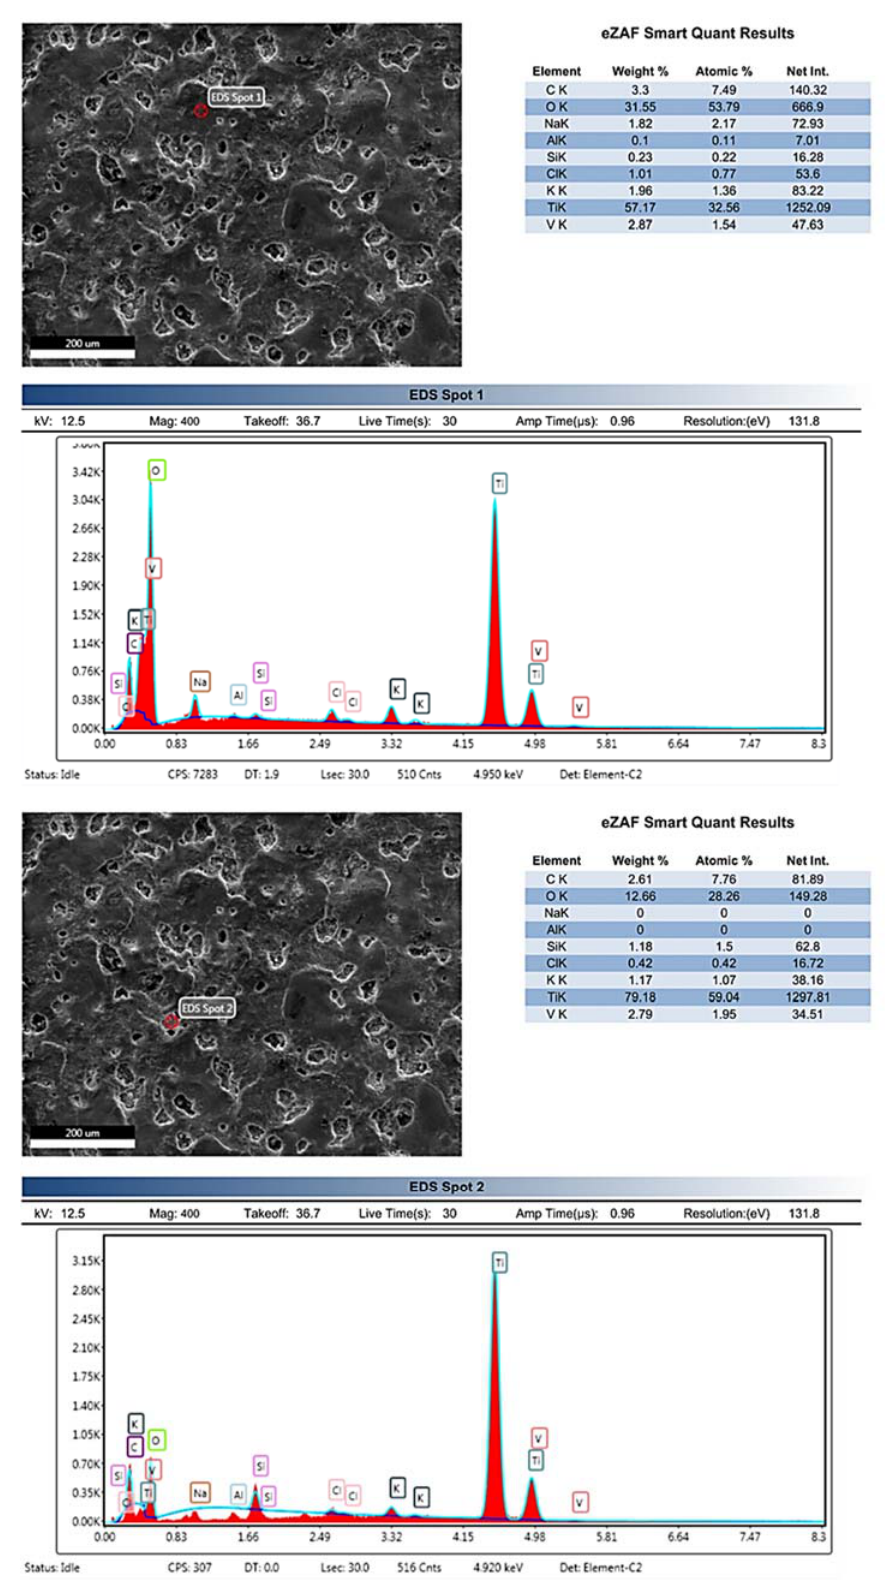
Figure 8. Energy Dispersive X-ray Spectroscopy: Si powder concentration 5 g / L, Ip 5 A, Ton 100 µ Sec (EDS Spot 1) Plain surface (EDS Spot 2) Crater.